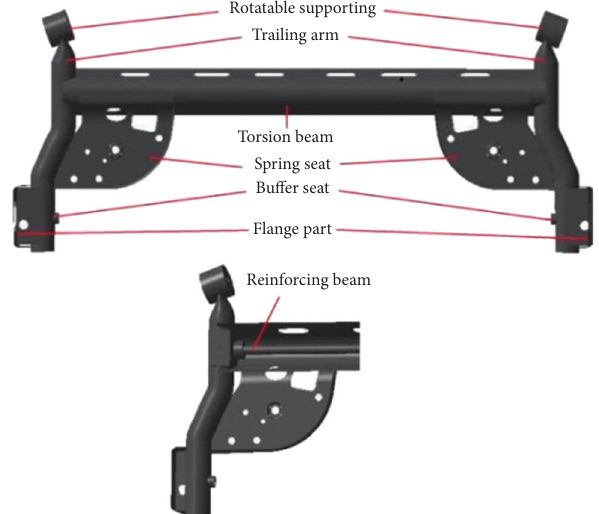
Figure 2: Target torsion beam rear